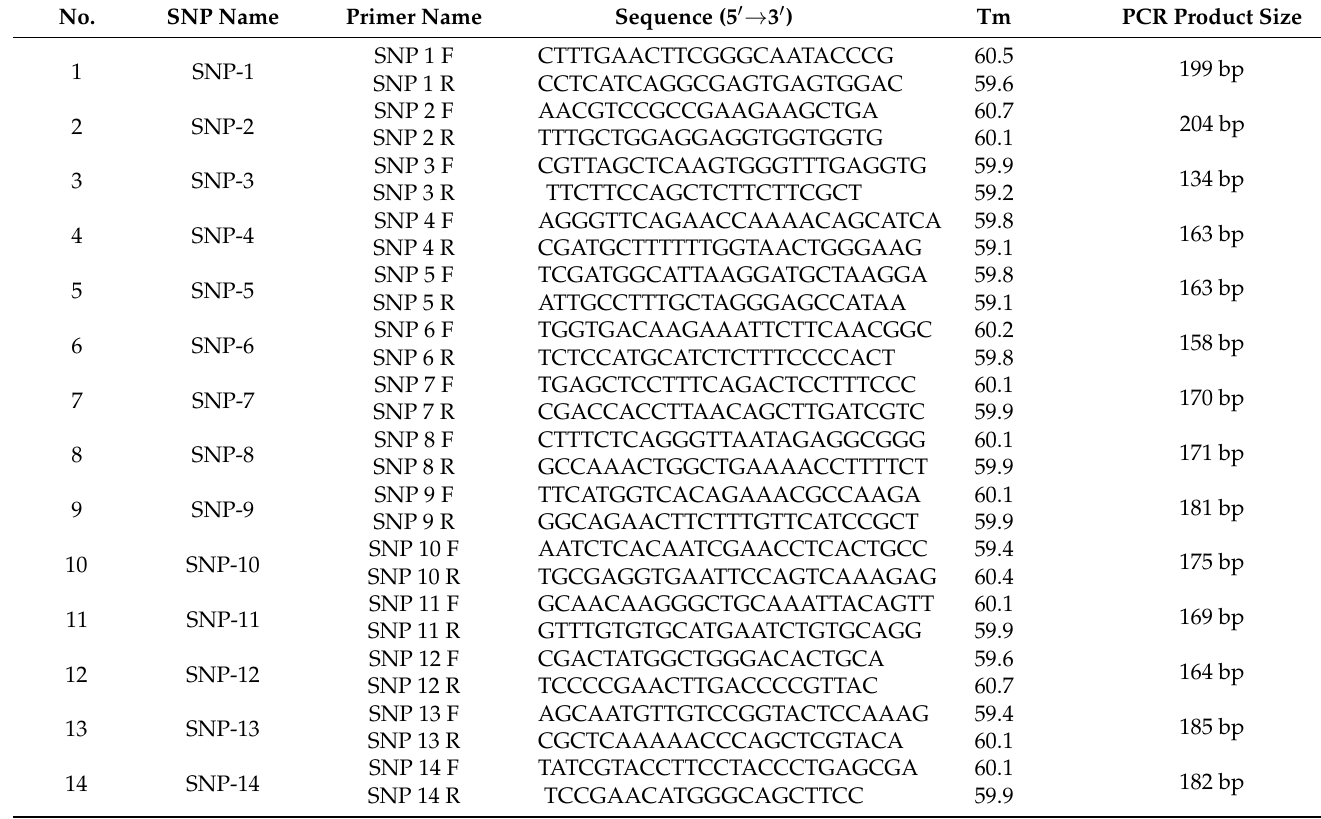
Table 1. HRM primers designed from 14 selected transcripts with SNPs that exist between the resistant and susceptible lines.